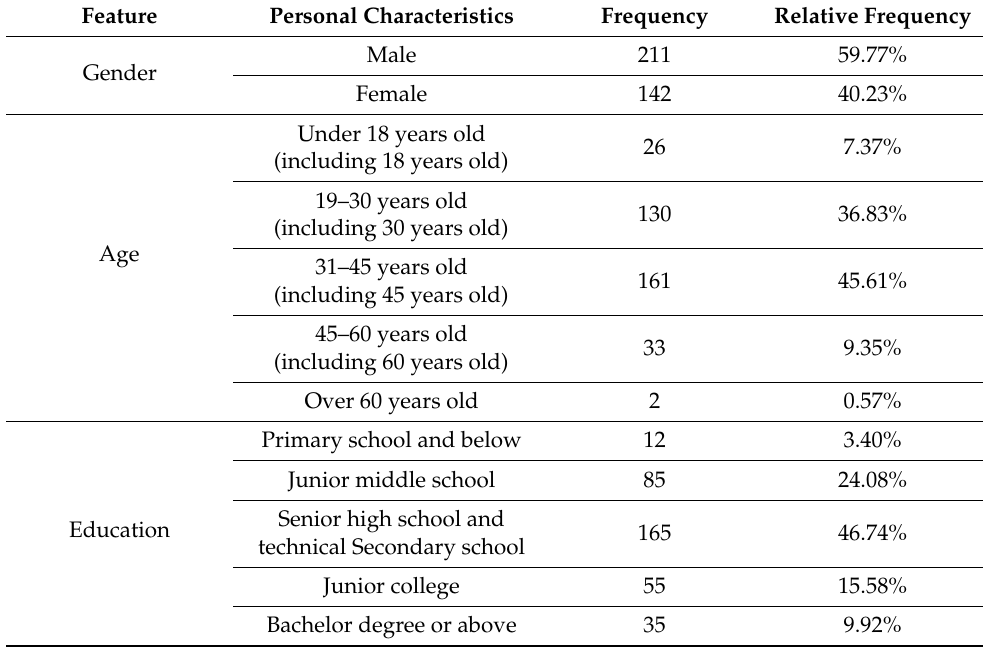
Table 3. Distribution of the characteristics of the survey